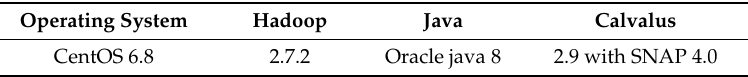
Table 1. Basic platform components. Basic platform components (Table 1):